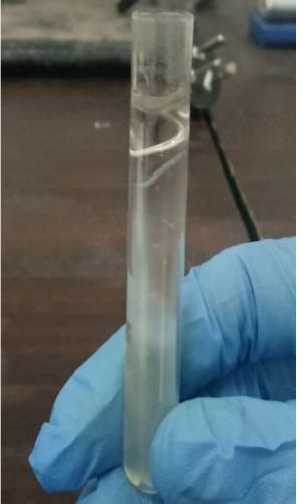
Figure 3. MMA repair material.